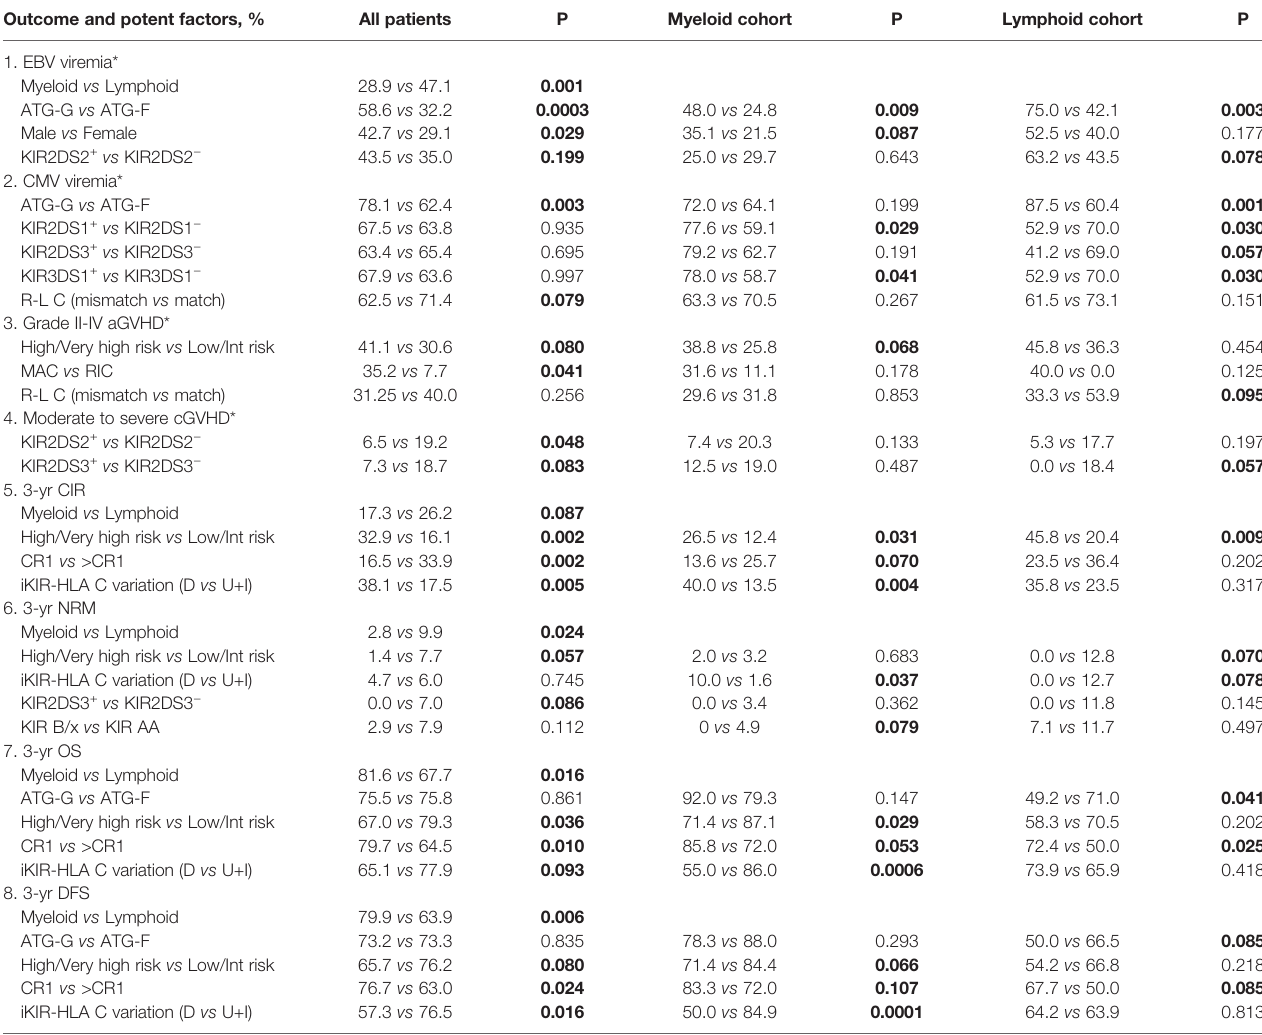
TABLE 2 | Univariate analysis of factors that in fl uence transplant outcomes. Outcome and potent factors, % All patients P